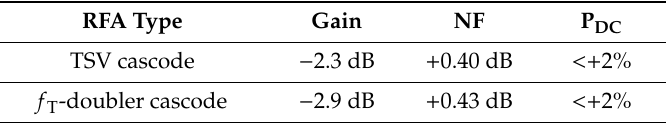
Table 2. X-ray Irradiation Results.